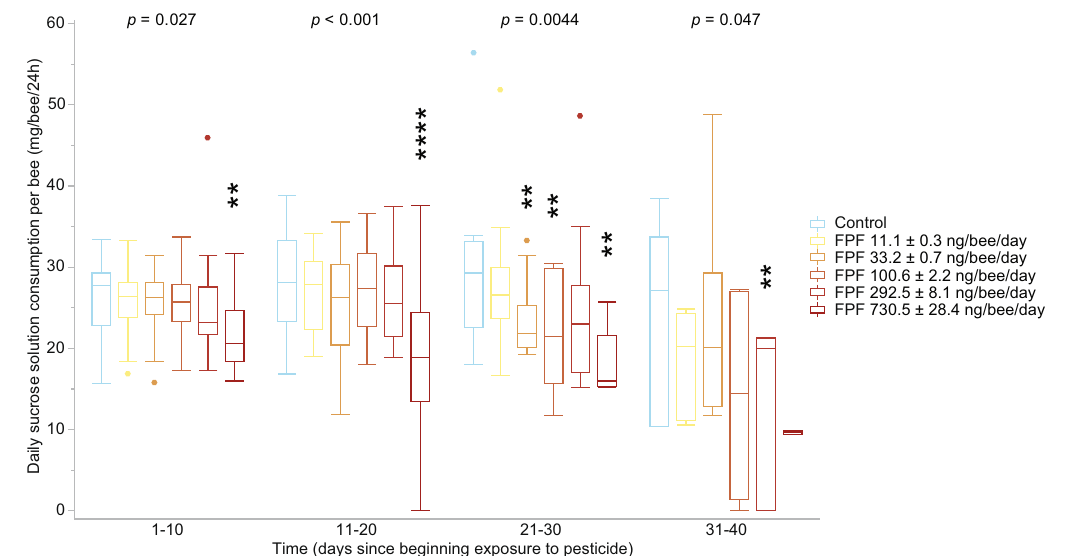
Fig. 2 Effects of fl upyradifurone (FPF) on daily sucrose solution consumption per bee. We assessed our results in time blocks of 10 days to facilitate comparison between the standard 10-day risk assessment chronic test and longer term exposures 36 . We report the signi fi cance of the main effect of FPF treatment above each time period (Supplementary Table 5). Asterisks indicate signi fi cant differences between the respective FPF dose (reported in ng/ bee/day, mean ± Standard Error of the Mean, SEM) and control (GLM DS ; n = 111; ** p < 0.01, **** p < 0.0001; Table 10). The box-plot reports the maximum (excluding outliers), the percentiles (75th, 50th, and 25th), the minimum (excluding outliers), and the outliers. Additional details, including effect sizes, are in Supplementary Tables 5 – 7.